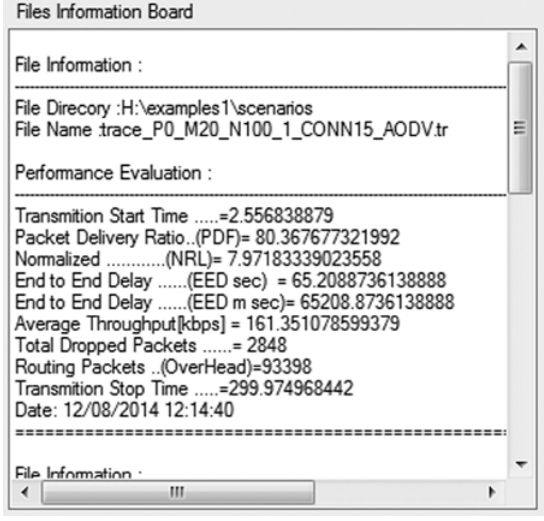
Figure 5. Results Report